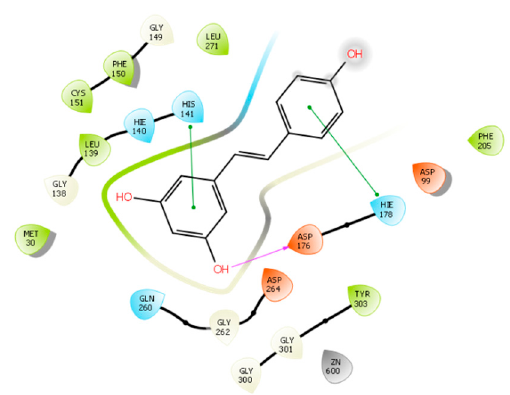
Figure 4. RVT interactions with HDAC-1 binding site.